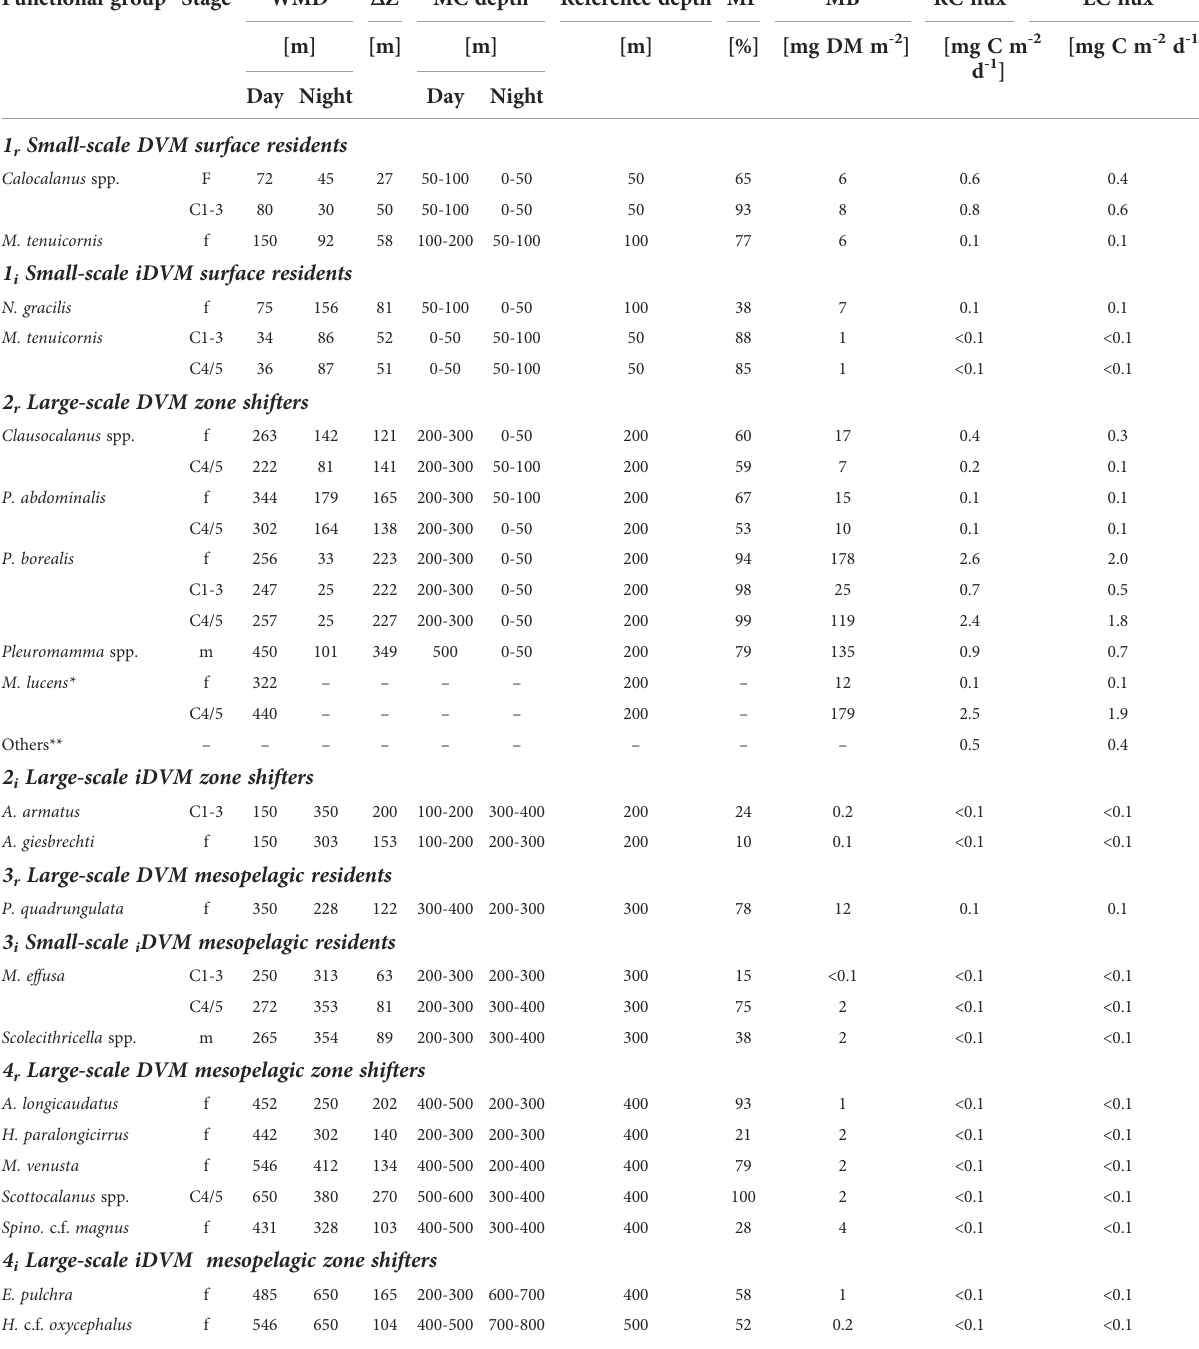
TABLE 1 Respiratory carbon (RC fl ux) and egestive carbon (EC fl ux) fl ux of the dominant diel vertical migrating copepods. Functional group